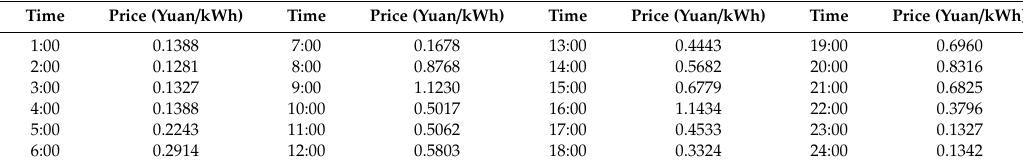
Table 7. The real-time price based on user’s load.